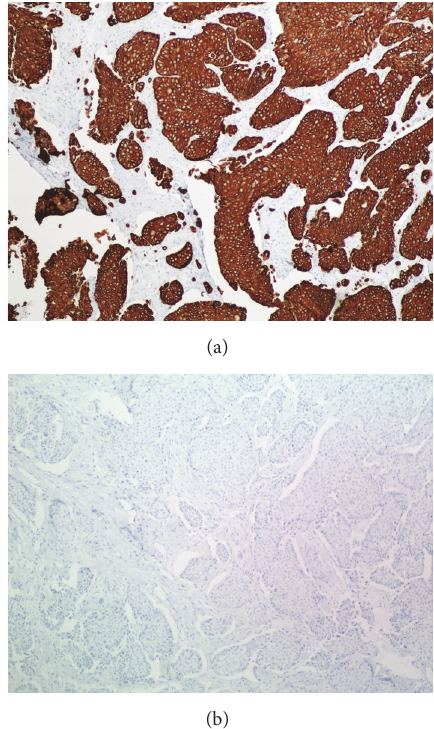
Figure 2: The carcinoma is positive for CK 7 (a) and negative for